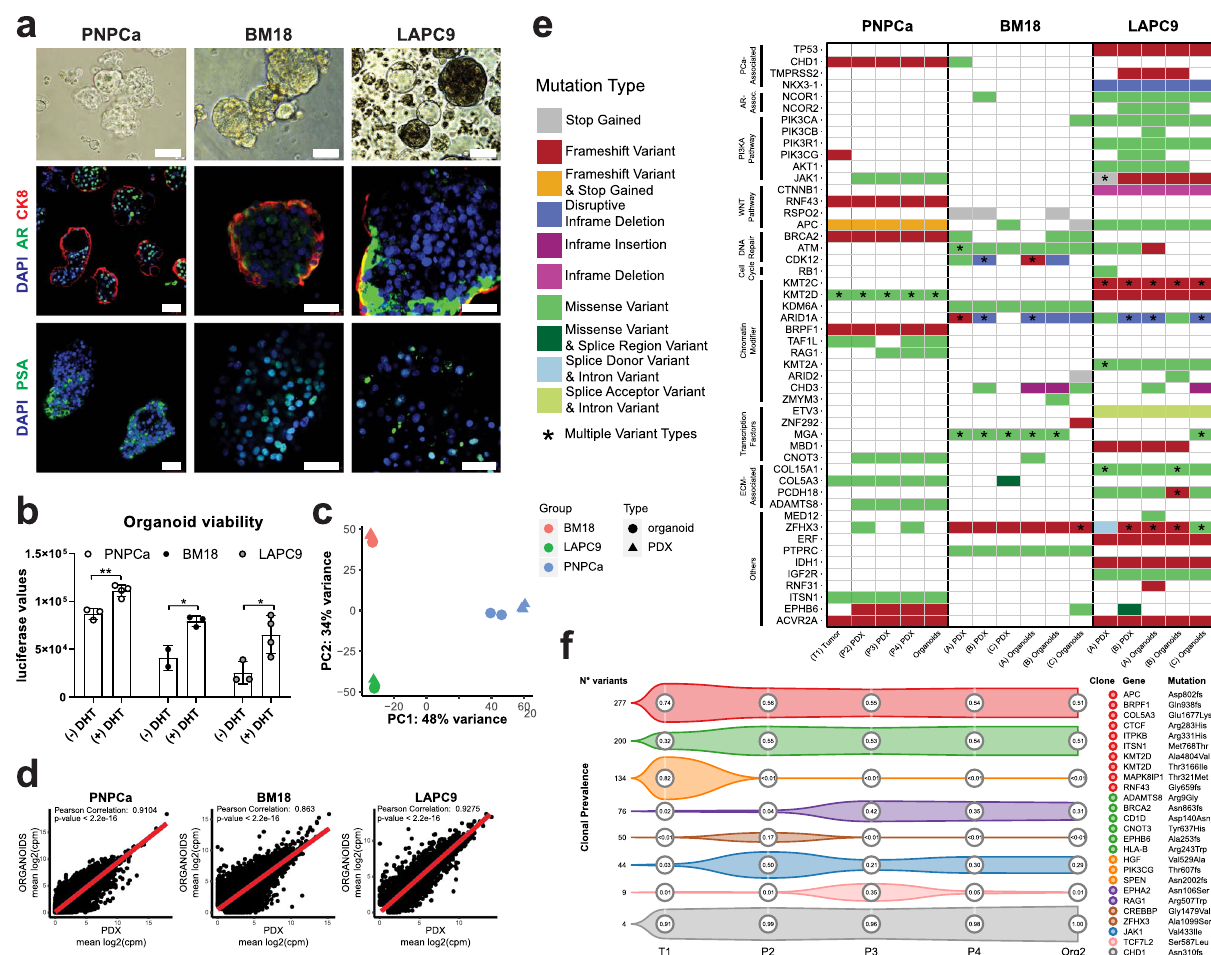
Fig. 2 Mutational landscape of PDX and PDX-derived organoids from PNPCa, and advanced androgen (in) dependent BM18 and LAPC9 models. a Morphology of PNPCa, BM18, and LAPC9 PDX-derived organoids; bright fi eld images, whole mount immuno fl uorescence staining and 3D projection of z-stack of organoids stained for PSA, AR, and CK8. DAPI marks the nuclei. Scale bars 50 μ m. b Viability assay of organoids derived from PNPCa, BM18, and LAPC9 tumor tissues and exposed to dihydrotestosterone (±DHT) for 48 h. Luciferase values (ATP release) are proportional to cell viability. Mean± SD is reported, N = 3,4 technical replicates per condition (PNPCa), N = 2,3 technical replicates per condition (BM18), N = 3,4 technical replicates per condition (LAPC9). Two-tailed t -test, * p = 0.0161, p = 0.0277, ** p = 0.0031. c Principal component analysis of the gene expression of the 1000 most variable genes on PNPCa, BM18, and LAPC9 samples (PDX and PDX-derived organoids). d Correlation plots of gene expression between PNPCa PDX tissue ( N = 3 biologically independent tumor samples) and organoids ( N = 2 biologically independent organoid samples), BM18 PDX tissue ( N = 2) and organoids ( N = 2), LAPC9 PDX tissue ( N = 2) and organoids ( N = 2), p- values < 2.2e10 − 16 . e Somatic mutation analysis of WES of tissue and organoids of PNPCa, BM18, and LAPC9 PDX. Columns represent different samples, while rows represent selected genes categorized by pathway. Types of genetic aberrations are indicated in different colors. Multiple types of mutations per gene are indicated with an asterisk. A – C indicate biological replicates. f Clonality analysis of the PNPCa samples shown in e , inferred by PyClone. Only the largest clones (consisting of most variants) or those containing cancer genes are shown. Numbers in circles indicate mean clonal prevalence, estimated for each sample. Mutations in cancer genes corresponding to each clone are reported on the left and color-coded. Overall, most mutations (including those in cancer genes) occur at high prevalence in all samples (top two clones). WES, whole- exome